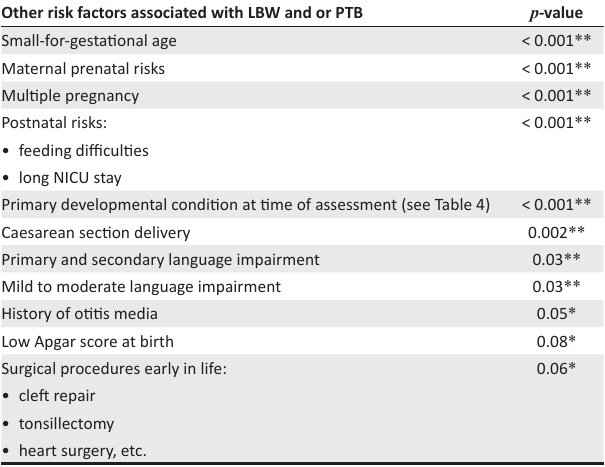
TABLE 6: Associations between preterm birth and/or low birth weight and other risk factors. Other risk factors associated with LBW and or